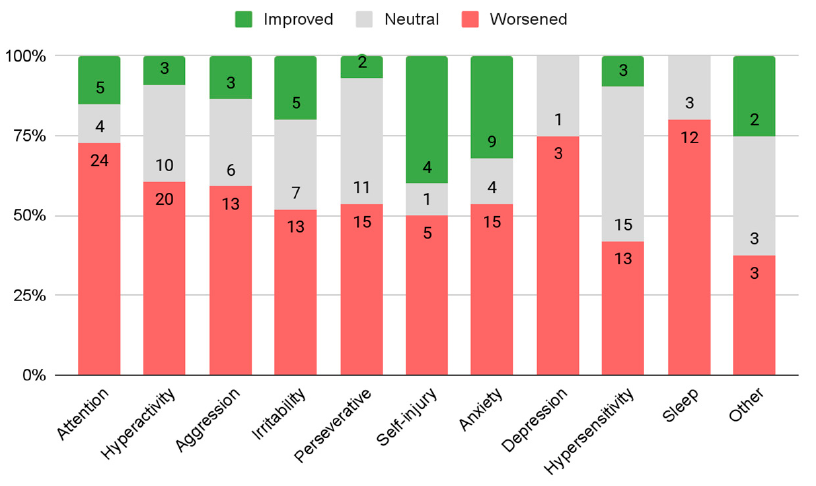
Figure 2. Reported change in behaviors.